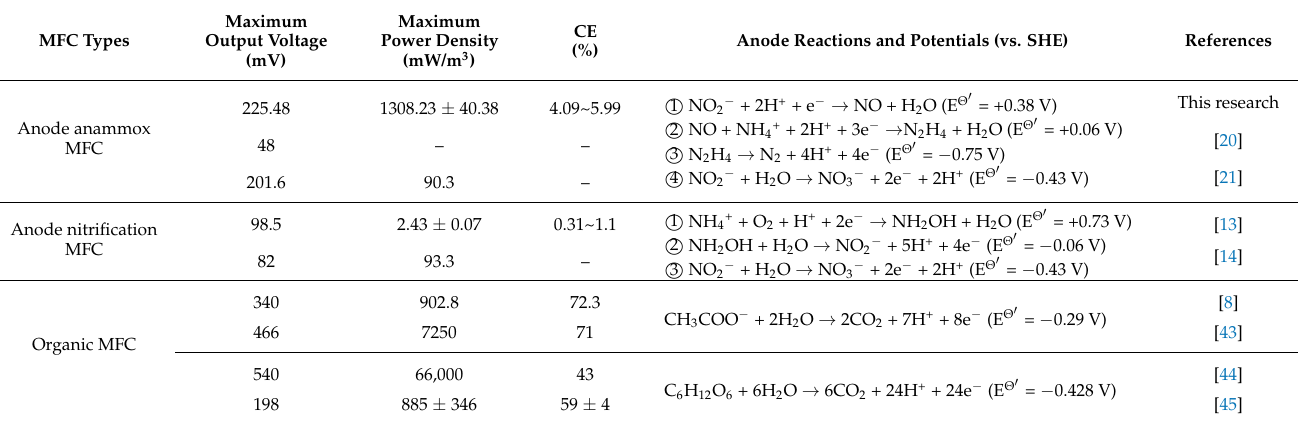
Table 1. Comparison of electricity generation in the anode anammox MFC, anode nitrification MFC and Organic